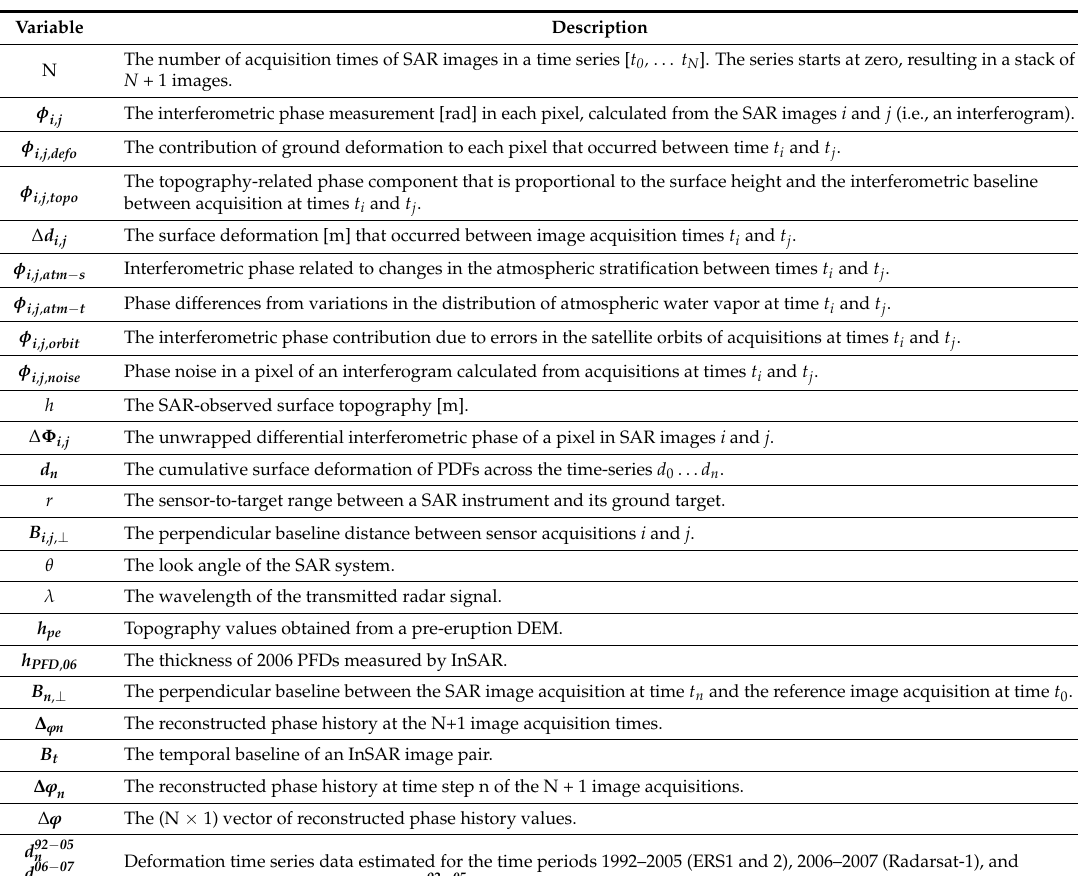
Table A1. Definitions of variables used in Section 4, Equations